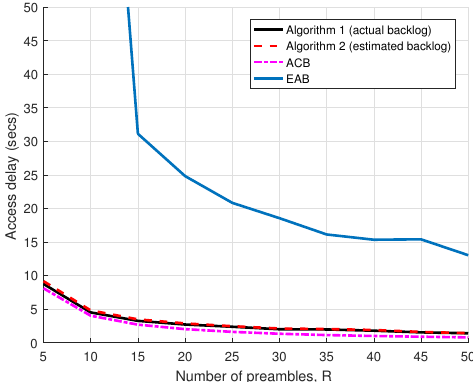
Figure 6. Average access delay vs. number of preambles, R .